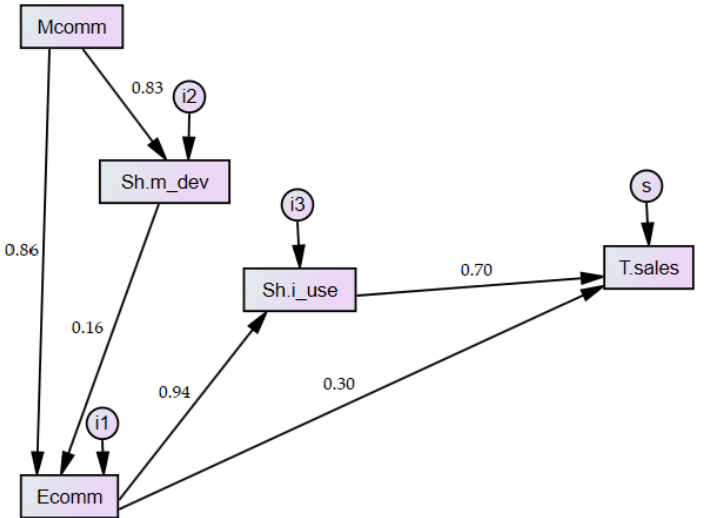
Figure 3. Importance of variables from the MLP model. Source: developed using SPSS v.20.